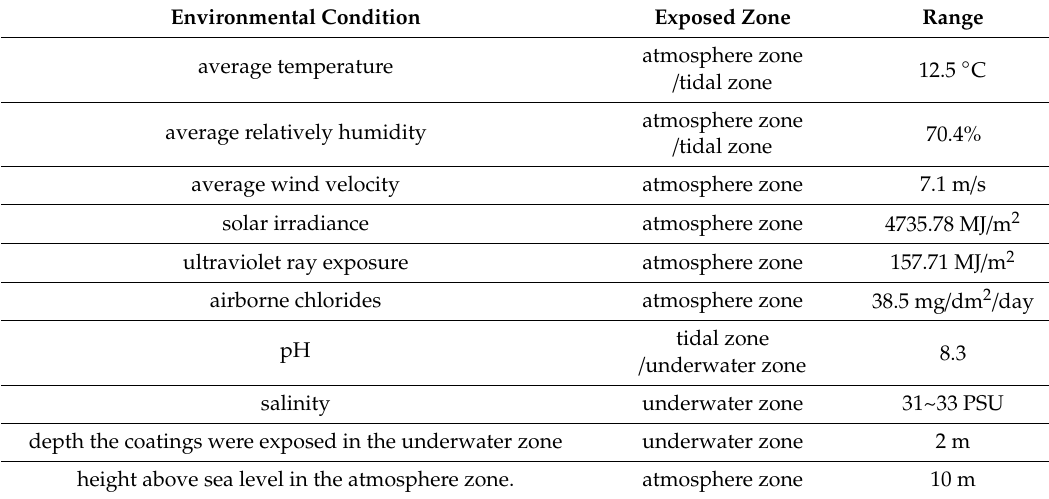
Table 2. Environmental conditions of the test